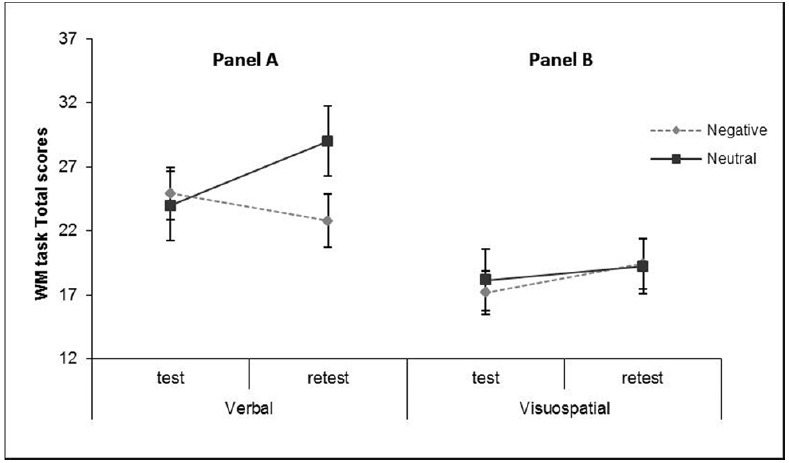
Three-way interaction effects of Emotional valence by Task modality by Test–retest on the WM performance scores, Experiment 1. The three-way interaction effects of Emotional valence by Task modality by Test–retest on the WM performance scores was found to be significant. (A) Simple effect analyses confirmed that for participants assigned to the Verbal session the performance scores significantly increased over time in the neutral condition, but remained stable in the emotional condition. (B) the Visuospatial performance remained substantially stable across emotional conditions over time. These findings indicate that the visual performance was generally unaffected by practice whereas the verbal performance was influenced by participants’ practice only in the neutral condition. Error bars represent ± 1 SE.